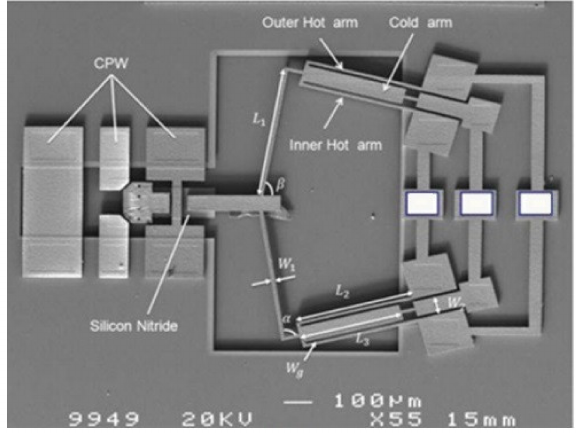
Figure 3. Bi-directional hot-and-cold-arm actuators: radio frequency (RF) switch